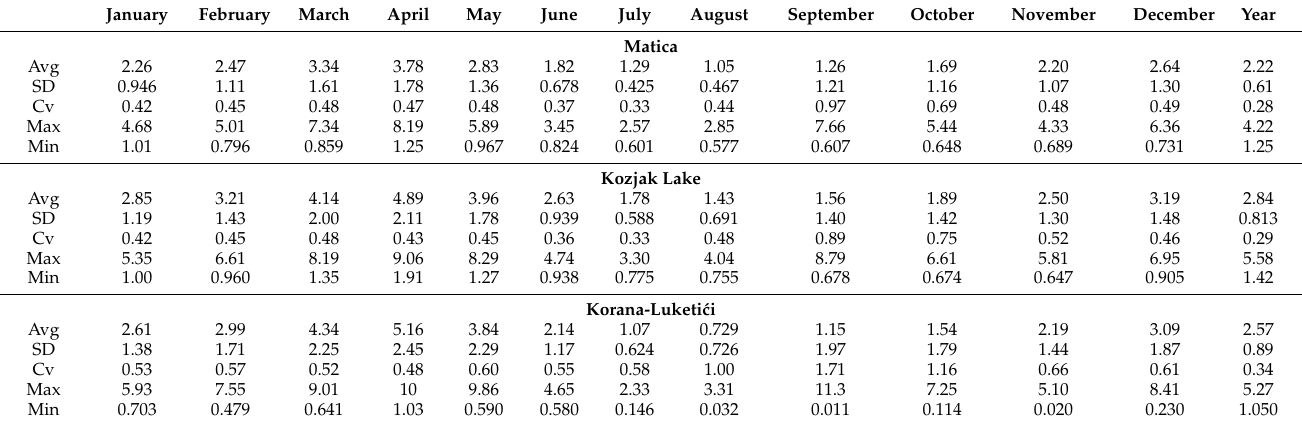
Table 3. Mean monthly and annual discharges (m 3 /s) at the Matica, Kozjak Lake, and Korana-Luketi´ci stations (1978–2020) (Note: Avg—average; SD—standard deviation; Cv—coefficient of variation; Max—maximum;